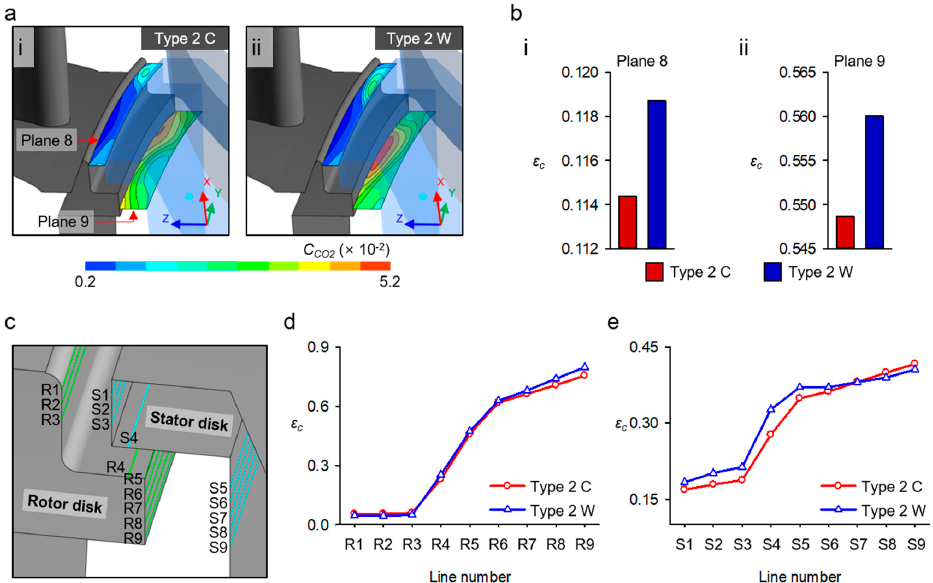
Figure 12. ( a ) Contour of C CO2 in Plane 8 near the mainstream path, and Plane 9 located adjacent to the rotor radial seal in the wheelspace; ( i ) Type 2 C and ( ii ) Type 2 W. ( b ) Comparison of